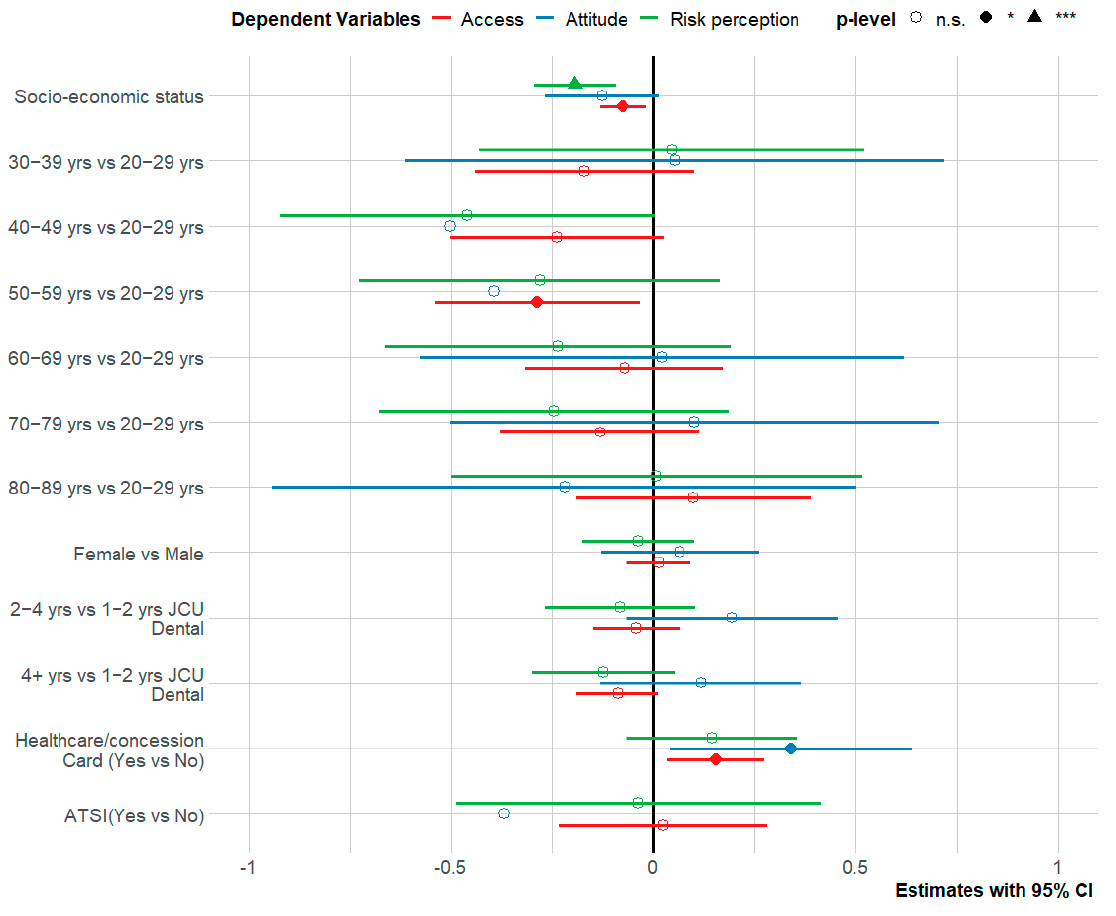
Figure 3. Effect of socio-demographic variables on risk perceptions, attitudes and access in multiple regression.